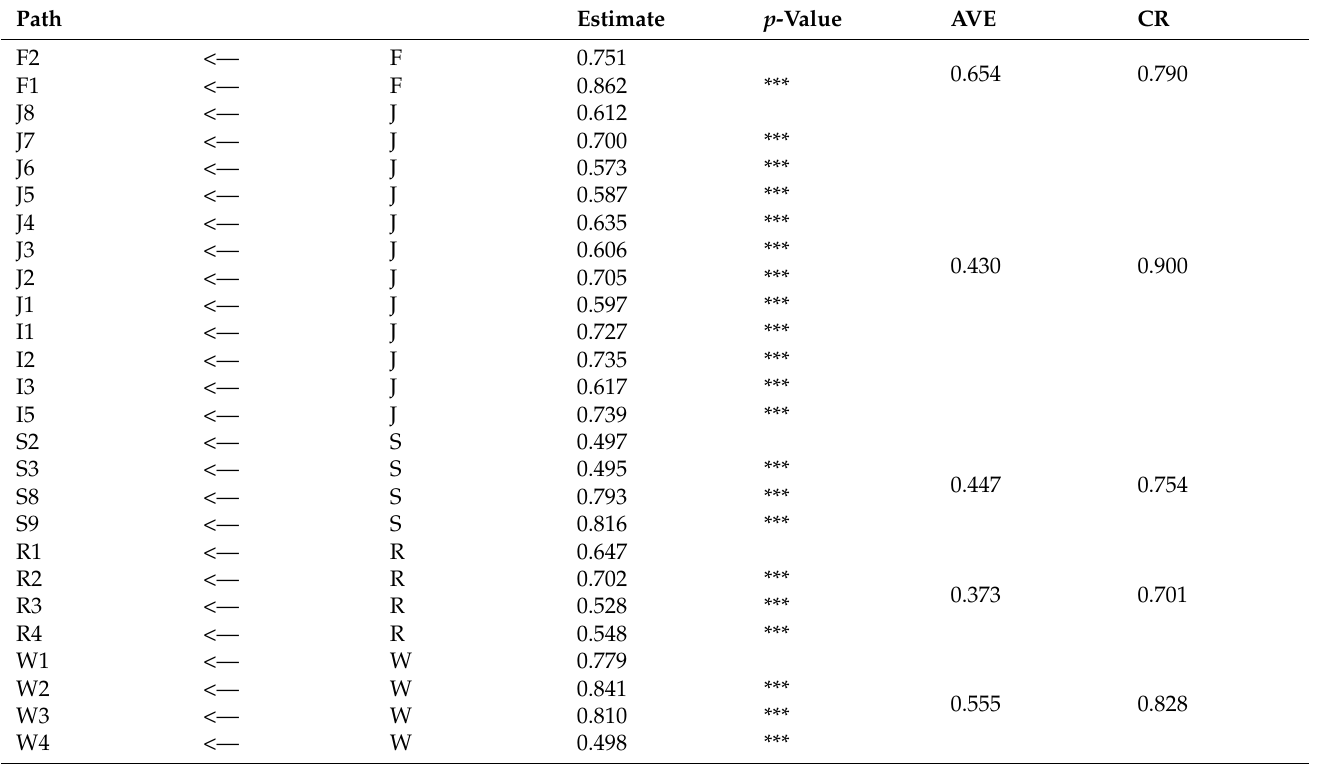
Table 7. Normalized Path Coefficients of Optimal Measurement